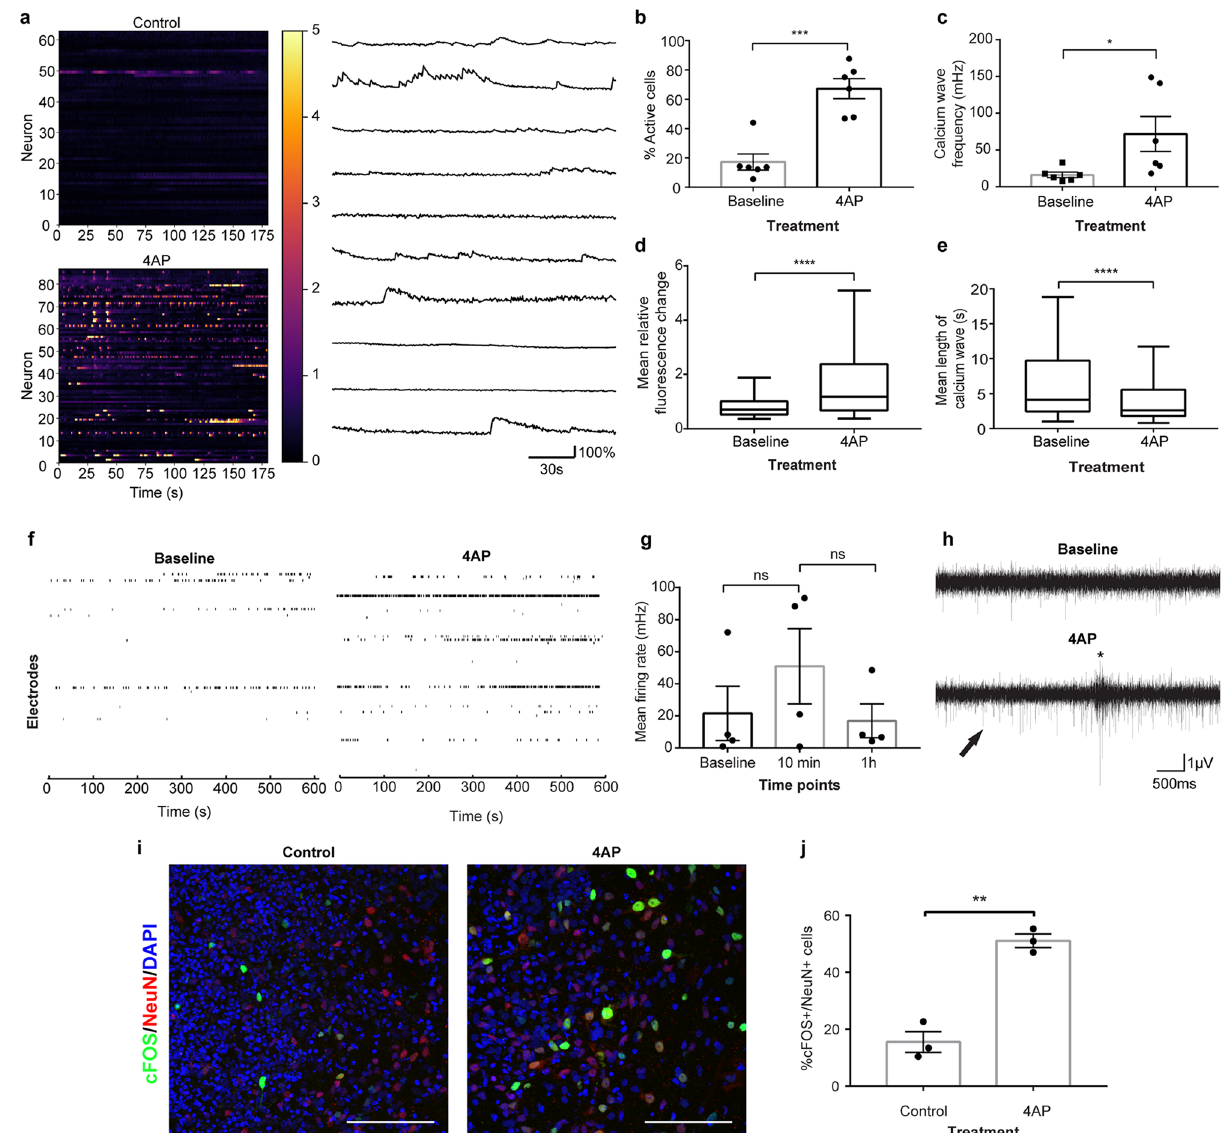
Figure 3. Effect of 4AP on neuronal activity in 90-day-old cerebral spheroids. ( a ) Left: Heatmap of calcium- associated fluorescence over time in a spheroid before exposure to 4AP (upper) and after exposure to 4AP (lower). Each line represents a different cell and the color bar represents the fold-change in calcium-associated fluorescence over each cell’s baseline. Right: Individual traces of calcium-associated fluorescence over time of representative cells ( b ) Proportion of active cells before and after treatment with 4AP. Student’s t -test, p = 0.0003. Bars represent mean ± SEM. Each dot represents an individual spheroid, n = 6 spheroids/condition *** p < 0.001. ( c ) Calcium wave frequency in active cells exposed or not to 4AP. Wilcoxon Rank Sum test, p = 0.0152. Bars represent mean ± SEM. Each dot represents an individual spheroid, n = 6 spheroids/condition * p < 0.05. ( d ) Mean calcium transient amplitude. The mean calcium transient amplitude was calculated for each cell from 6 individual spheroids for each condition (n = 282 cells in 4AP group and 95 cells in Baseline group. Wilcoxon Rank Sum test, p < 0.0001. The line represents the median, sides of the box represent the upper and lower quartile and whiskers represent maximum and minimum values. **** p < 0.0001. ( e ) Mean calcium transient duration. The mean calcium transient duration was calculated for each cell from 6 individual spheroids for each condition (n = 282 cells in 4AP group and 95 cells in Baseline group. Wilcoxon Rank Sum test, p < 0.0001. The line represents the median, sides of the box represent the upper and lower quartile and whiskers represent maximum and minimum values. **** p < 0.0001. ( f ) Representative raster plot of neuronal spikes before (left) and after ( right ) exposure to 100 µM 4AP. Each line represents an individual electrode. ( g ) Mean firing rate upon exposure to 4AP. ANOVA repeated measures with Holm Sidak’s correction for multiple comparisons, F (1,439, 4,316) = 0.6389 p = 0.5226. Each dot represents an individual spheroid, n = 4 spheroids/condition. Bars represent mean ± SEM. ns: not significant. ( h ) Example traces of local field potentials recorded before (upper) and after (lower) 10-min exposure to 4AP showing an increase in spikes (arrow) as well as the presence of bursts (*). ( i ) Representative immunofluorescence image of cFOS + /NeuN + recently active neurons in spheroids exposed to vehicle (left) or 4AP (right). Bar = 100 µm. ( j ) Proportion of cFOS + /NeuN + in NeuN + neurons in spheroids exposed or not to 4AP. Student’s t-test, p = 0.0034. Bars represent mean ± SEM. Each dot represents an individual spheroid. **p <